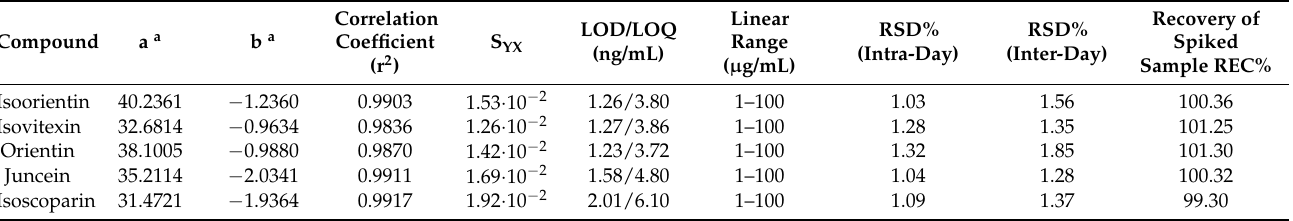
Table 1. Regression equations, correlation coefficients (r 2 ), standard deviation (S YX ), limits of detec- tion (LOD), limits of quantification (LOQ), and linear ranges for six reference